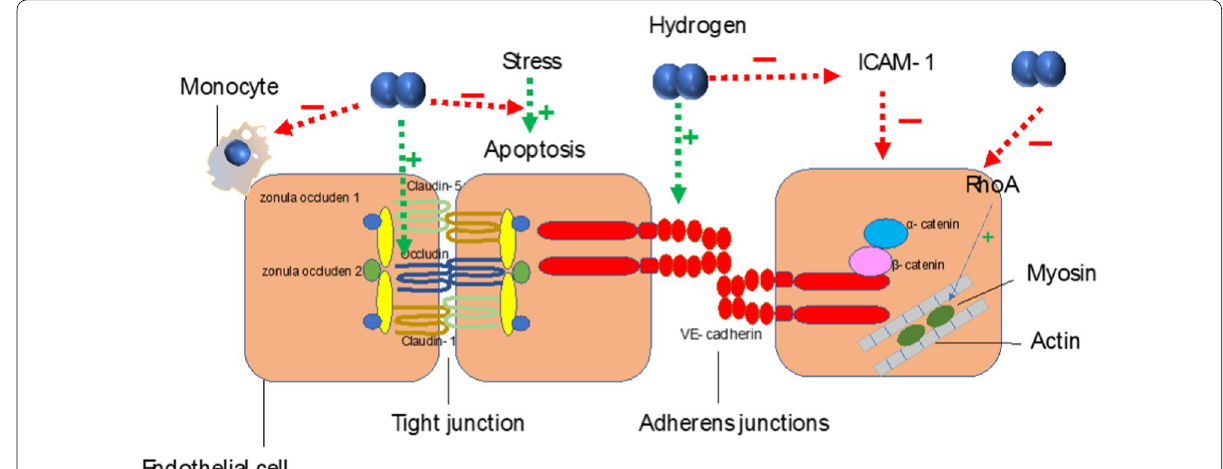
Fig. 3 Molecular hydrogen alleviates the hyperpermeability of the vascular endothelium in ALI. The interendothelial junctions of ECs include tight junctions and adherens junctions. Occludin and claudins are linked to the zonula occludens. The cytoplasmic domain of VE-cadherin binds to α-catenin and β-catenin to firmly maintain EC–EC junctions. RhoA activates Rho kinases and myosin light chain kinase, which phosphorylates the myosin light chain, inducing actomyosin contractility and weakening endothelial cell–cell adhesion. Molecular hydrogen could increase the expression of VE-cadherin and occludin. It also inhibits the expression of RhoA, reduces the expression of ICAM-1 and its release from the cell, and inhibits the adhesion of monocytes to